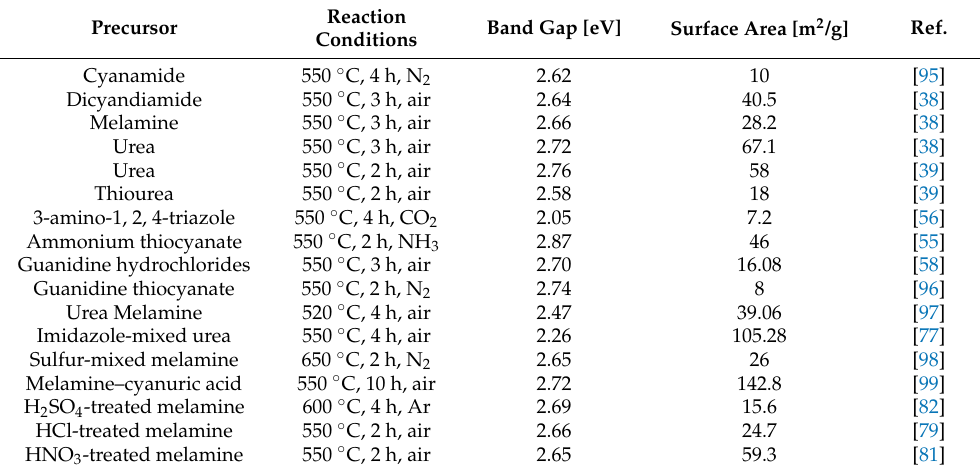
Table 1. Surface area and band gap of g-C 3 N 4 synthesized under different preparation conditions.